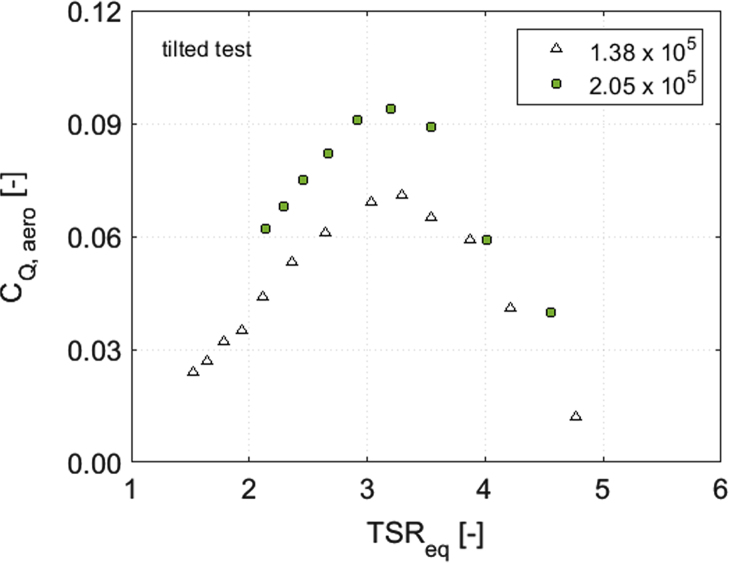
CQ curves for the tilted rotor at 200 rpm (Re=1.38×105) and 300 rpm (Re=2.05×105).